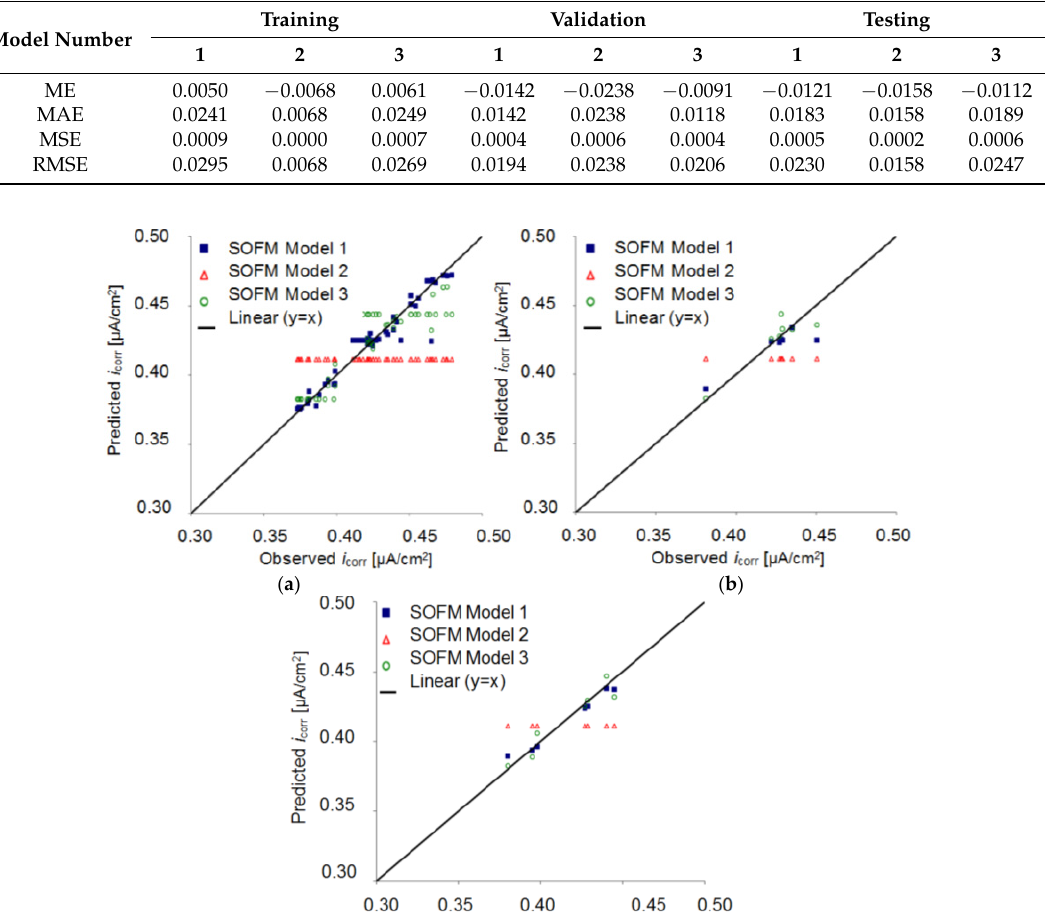
Table 6. Statistical analysis of the different SOFM models in training, validation, and testing.